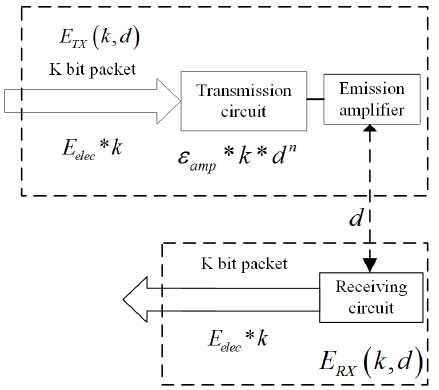
Figure 3. Schematic diagram of energy